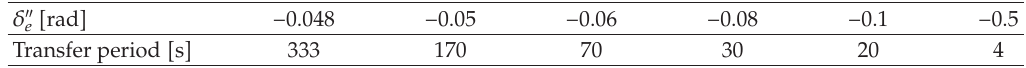
Table 2: The transfer periods of the transitions corresponding to the maneuver δ (cid:6) − 2 . 216 ◦ → δ (cid:6)(cid:6) e